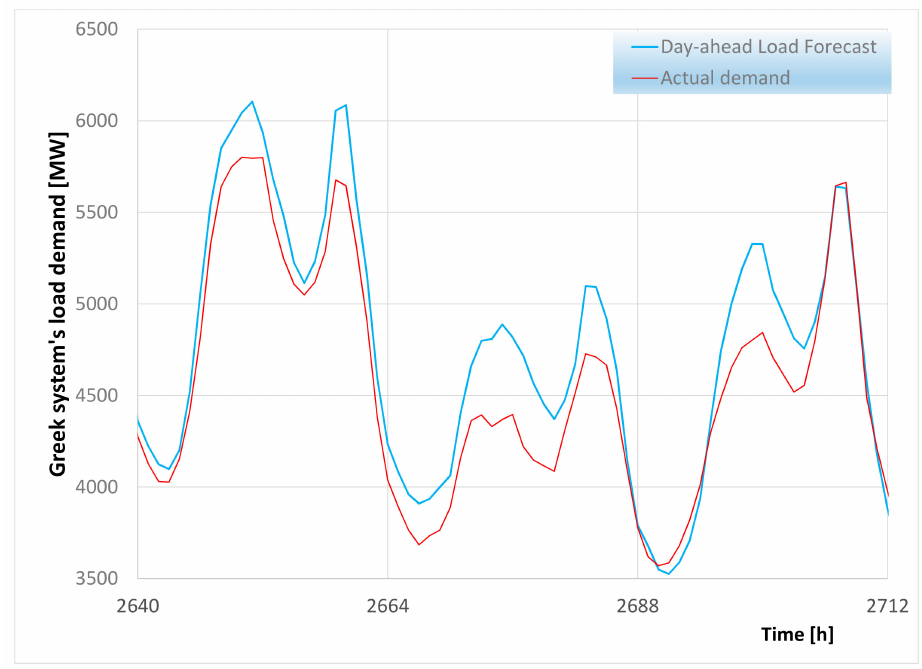
Figure 5. Load prediction failure during the period Wednesday 20 to Friday 22 April, 2022 (sudden weather improvement) [35]. Maximum relative error is